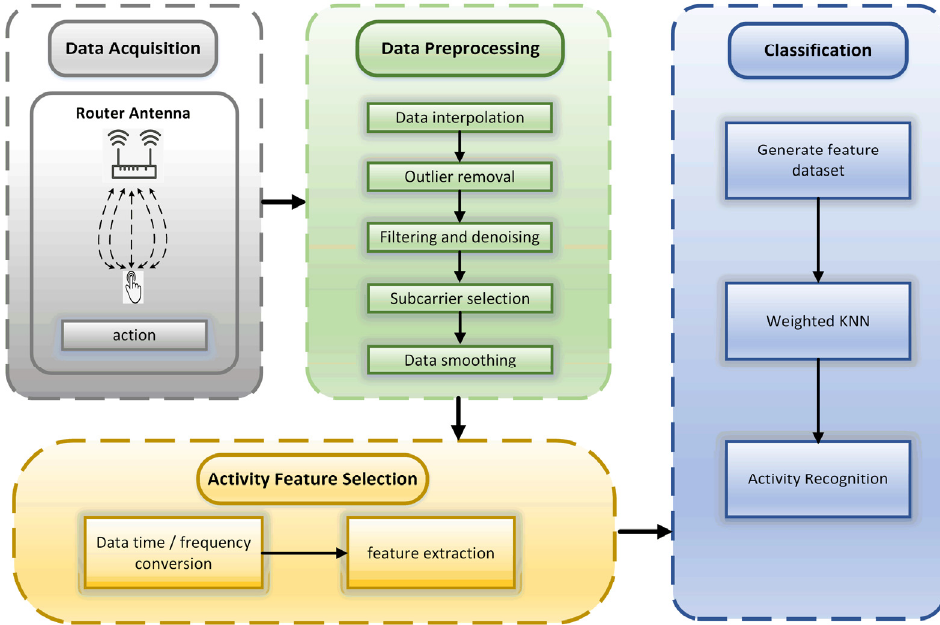
Figure 1. Overview of the Wi ‐ NN system.